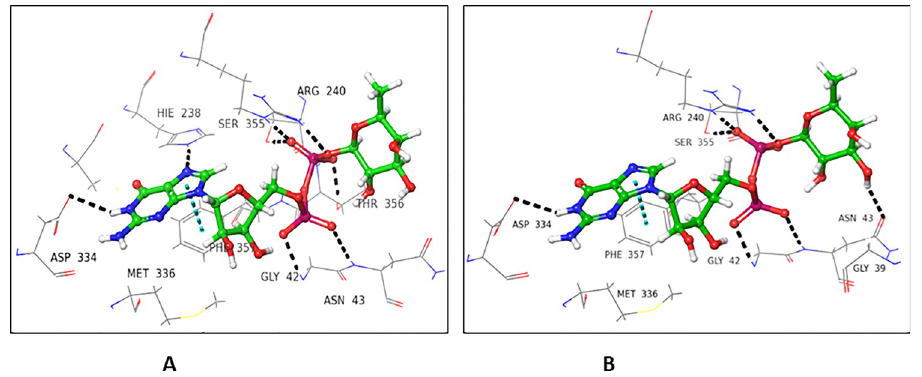
Fig 1. GDP fucose interactions with (A) native, and (B) mutated 3ZY5.